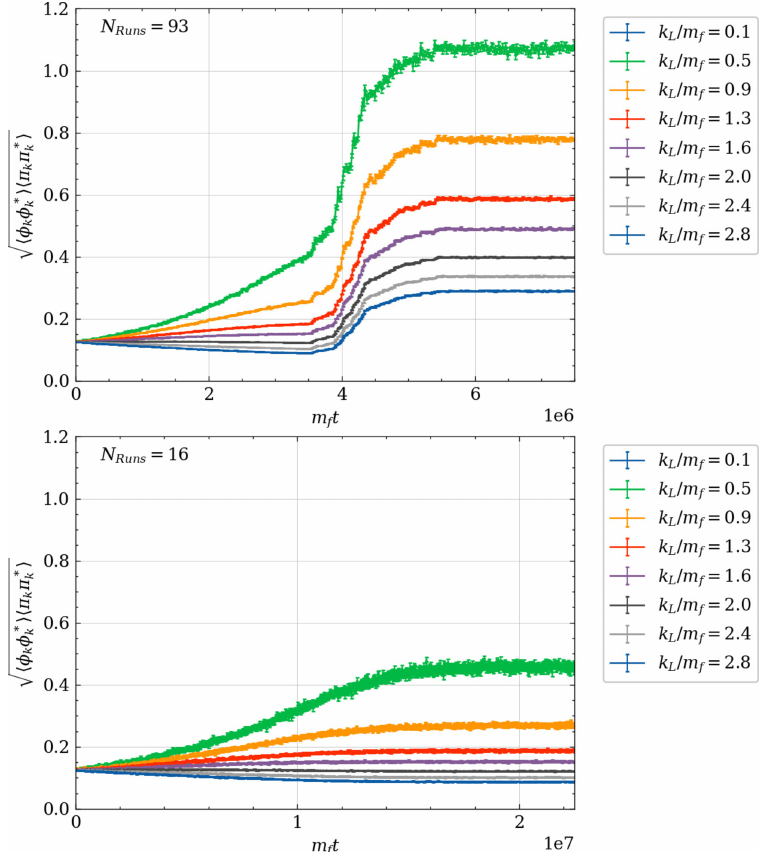
Figure 19 . Time evolution of occupation numbers for simulations with N x = 128 , (cid:15) = 0 . 5 and different values of φ